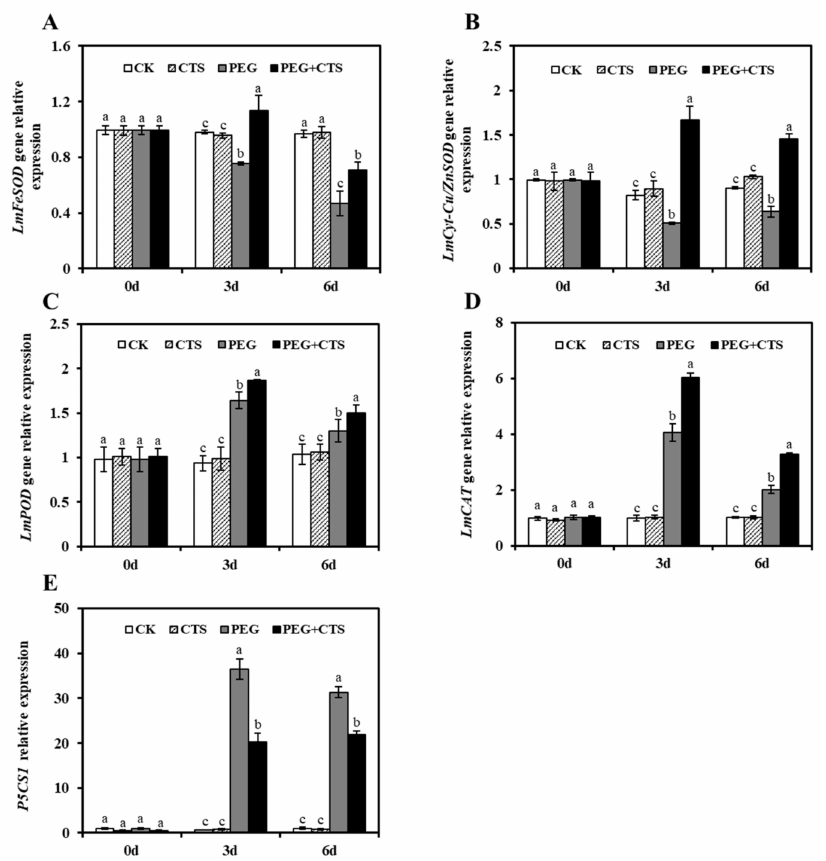
Figure 5. E ff ect of chitoscan (CTS) pre-treatment on expression level of genes LmFeSOD ( A ), LmCyt-Cu / ZnSOD ( B ), LmPOD ( C ), LmCAT ( D ), and P5CS1 ( E ) under osmotic stress condition. The relative expression levels were normalized to that of LmActin and presented using the 2 − ∆∆ Ct method. Vertical bars represent mean values ± SD for each mean. Di ff erent letter indicates significant di ff erences at given day ( P ≤